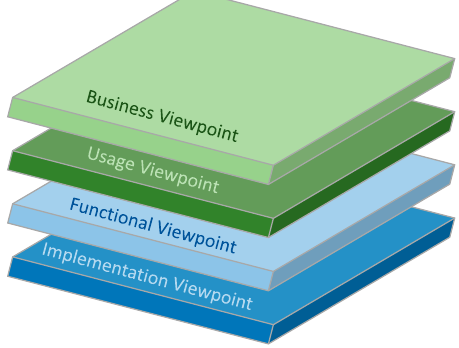
Figure 6. Industrial Internet Reference Architecture (IIRA) Reference Architecture Viewpoints.